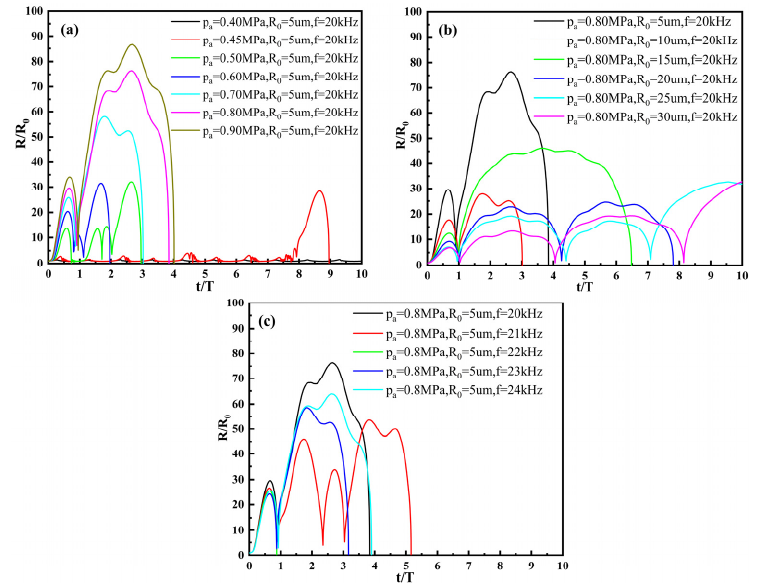
Figure 16. Influence of characteristic parameters on cavitation process. ( a ) Ultrasonic amplitude; ( b ) initial radius; ( c ) ultrasonic frequency. When the radius of cavitation bubbles and ultrasonic frequency are certain, the evo- lution law of the bubble’s radius with different sound pressures from 0.40 MPa to 0.90 MPa is shown in Figure 16a. The results indicate that only when the sound pressure in the molten pool is much higher than the cavitation threshold can the radius of cavitation bub- bles vary significantly. The cavitation bubbles with various radii are invariably in the con- dition of moderate amplitude and nonlinear oscillation at an acoustic pressure of 0.8 MPa; some do not even collapse within ten sound pressure cycles, as shown in Figure 16b. Based on the R–P equation to predict the effect of ultrasonic frequency on cavitation bubble radius, Figure 16c shows that under the sound pressure field with the sound pres- sure of 0.8 MPa and the initial radius of 5 µm, the collapse times of the cavitation bubbles at frequencies of 20 kHz, 21 kHz, 22 kHz, 23 kHz and 24 kHz are 3.85 T, 5.16 T, 0.87 T, 3.16 T and 3.90 T, respectively. Moreover, the maximum radii of the cavitation bubbles during dynamic evolution are 76.36, 53.57, 25.50, 58.62 and 63.88 times the initial radius, respec- tively. At an ultrasonic frequency of 20 kHz, the intensity of cavitation is guaranteed to include higher radius variation and moderate collapse time. Some experimental observa- tions indicated that when the ultrasonic frequency increased to a certain value, no ultra- sonic cavitation occurred or cavitation could not be detected, resulting in a more stable pressure value in the flow field [39]. The main reason for this anomaly is that at higher ultrasonic frequencies, the cavitation bubbles do not have enough time to expand and contract under the effect of alternating strong positive and negative pressures, and the